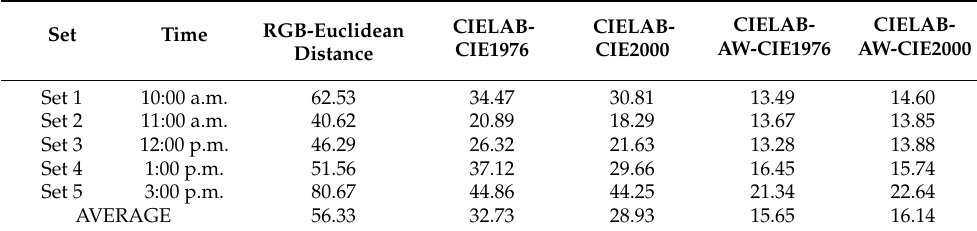
Table 3. Google Pixel average prediction rank using RGB and CIELAB colour model and three dis- tance functions—Euclidean distance, CIE1976, and CIE2000. AW—Proposed added weight difference from Table 4.